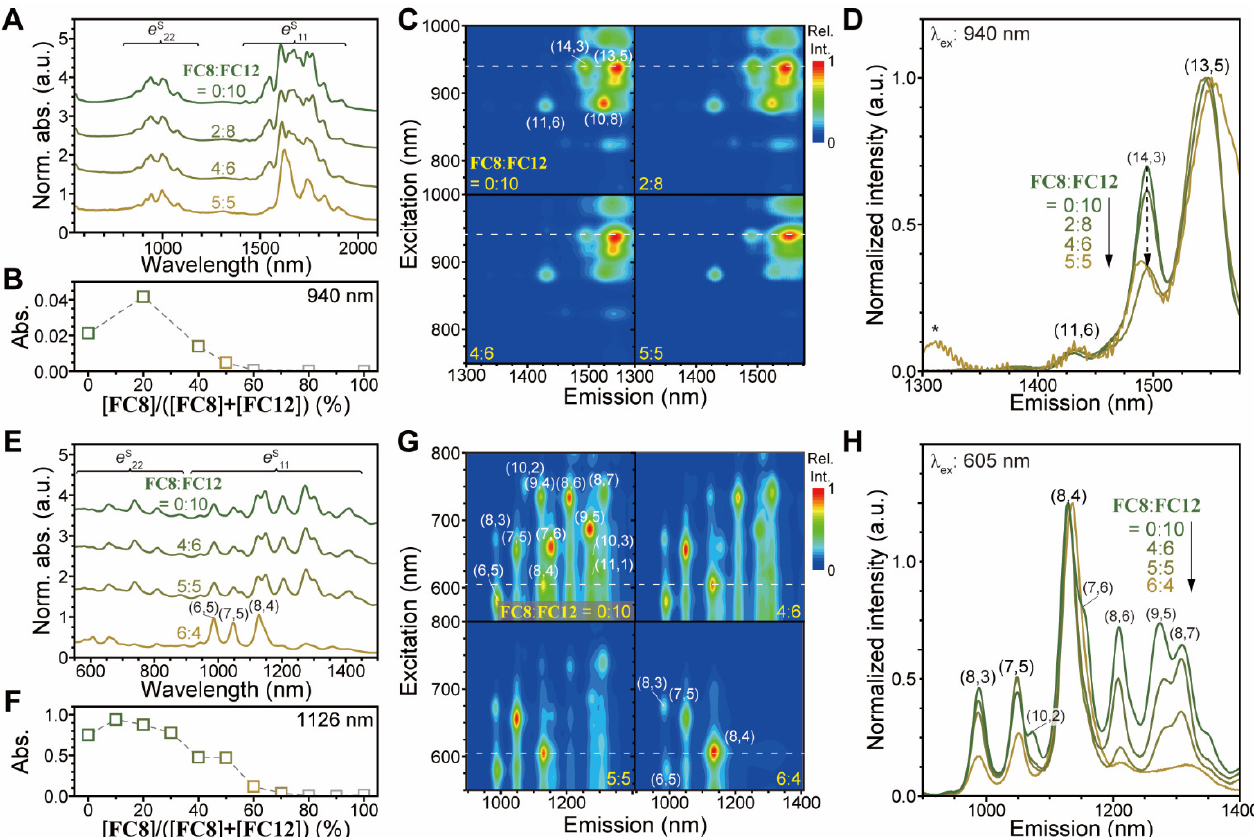
Figure 13. Kinetically driven chirality enrichment behavior of FC8 / FC12 with PSWNT and HiPco SWNT types. PSWNT: ( A ) The absorption spectra of PSWNT prepared by varying ratios of FC8 / FC20 while the total concentration of flavins remains the same (0.61 mM). The spectra were normalized against maximum e S22 bands at 940 nm and offset by same interval. ( B ) Absorbance trend of the 1623-nm peak according to the ratio. ( C ) The corresponding PLE maps and ( D ) PL emission spectra of PSWNT according to the ratio. HiPco: ( E ) The absorption spectra of HiPco prepared by varying ratios of FC8 / FC20 while the total concentration of flavins remains the same (2.44 mM). ( F ) Absorbance trend of the 1126-nm peak according to the ratio. ( G ) The corresponding PLE maps and ( H ) PL emission spectra of PSWNT according to the ratio.